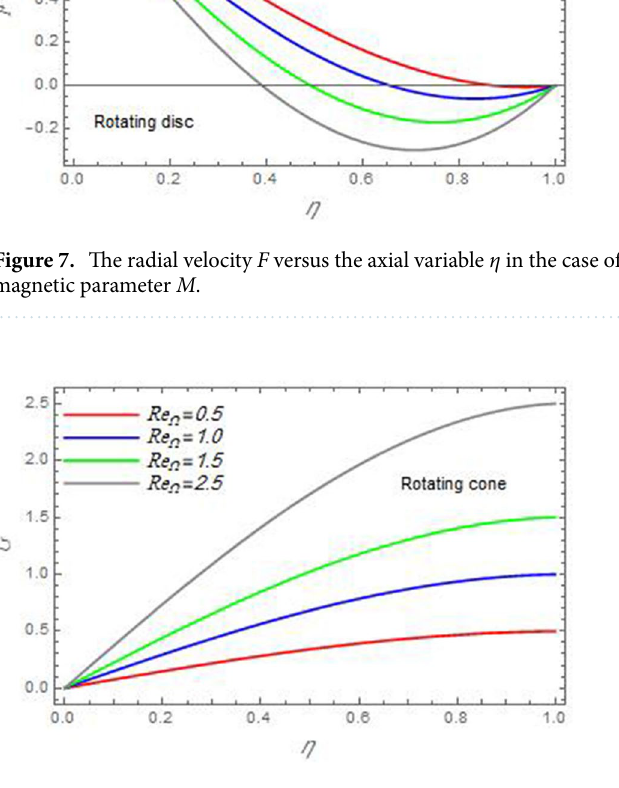
Figure 8. The azimuthal velocity G is plotted versus the axial variable η in the case of stationary disc to depict the effect of the Reynolds number Re (cid:31) .